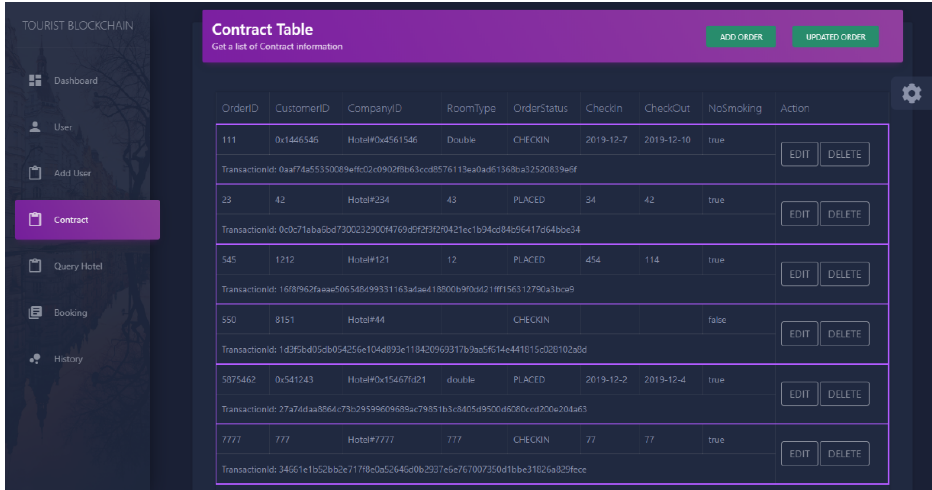
Figure 22. Screenshot of the contract dashboard.